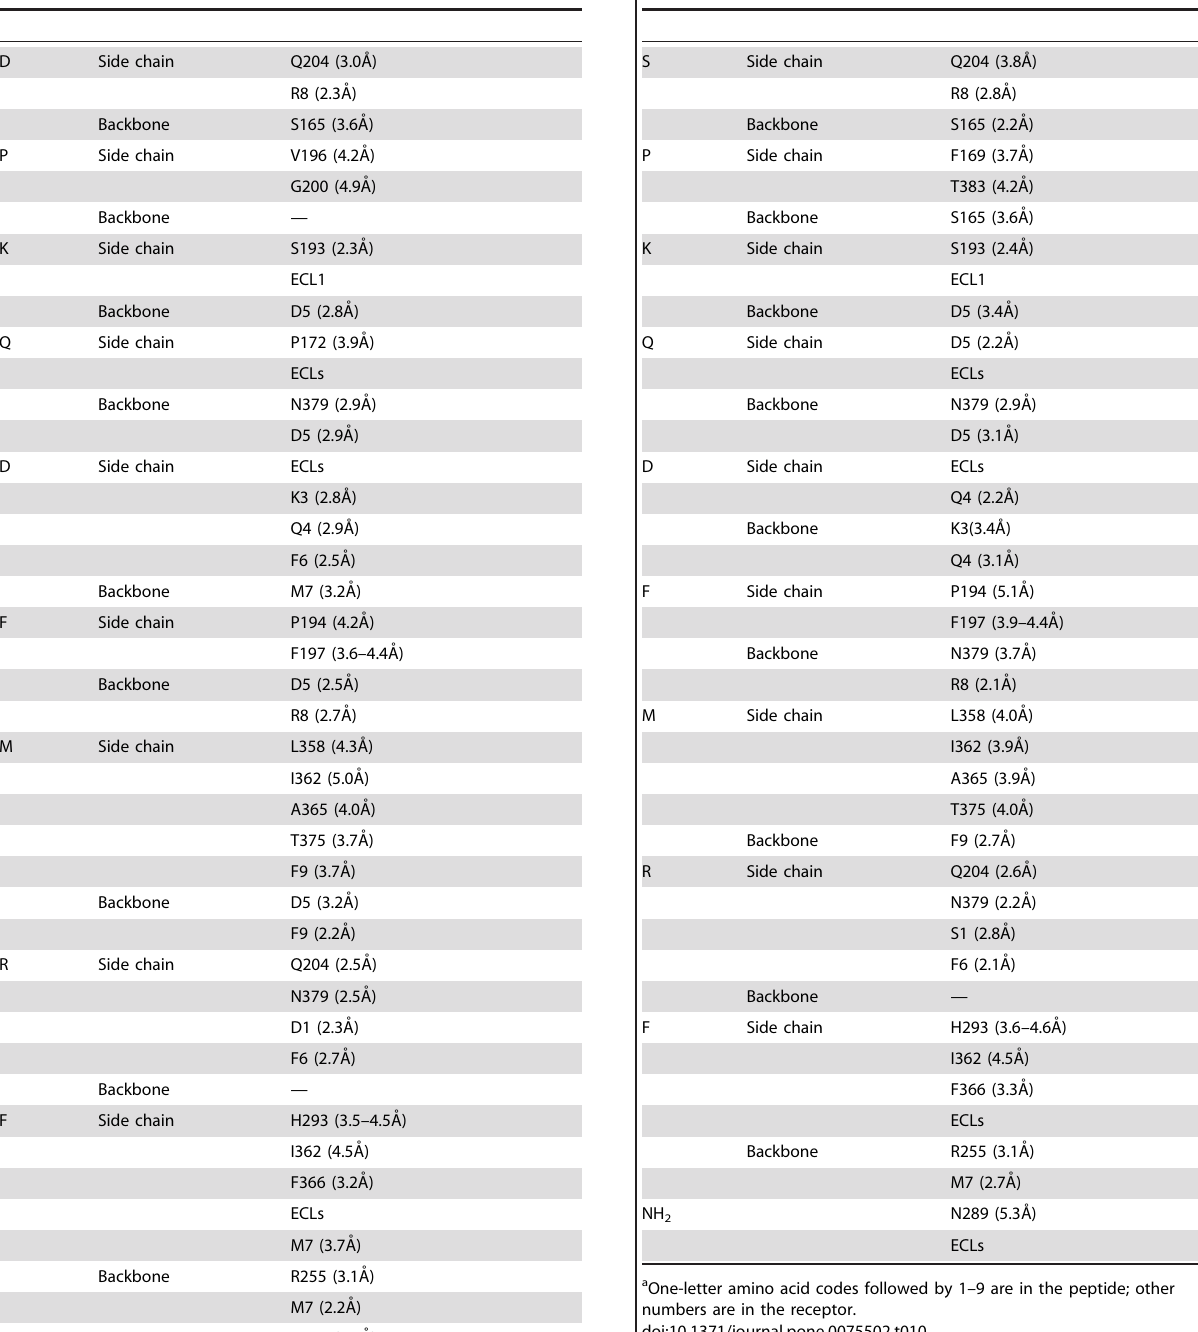
Table 9. DPKQDFMRF-NH 2 ligand-receptor contact sites a . Table 10. SPKQDFMRF-NH 2 ligand-receptor contact sites a